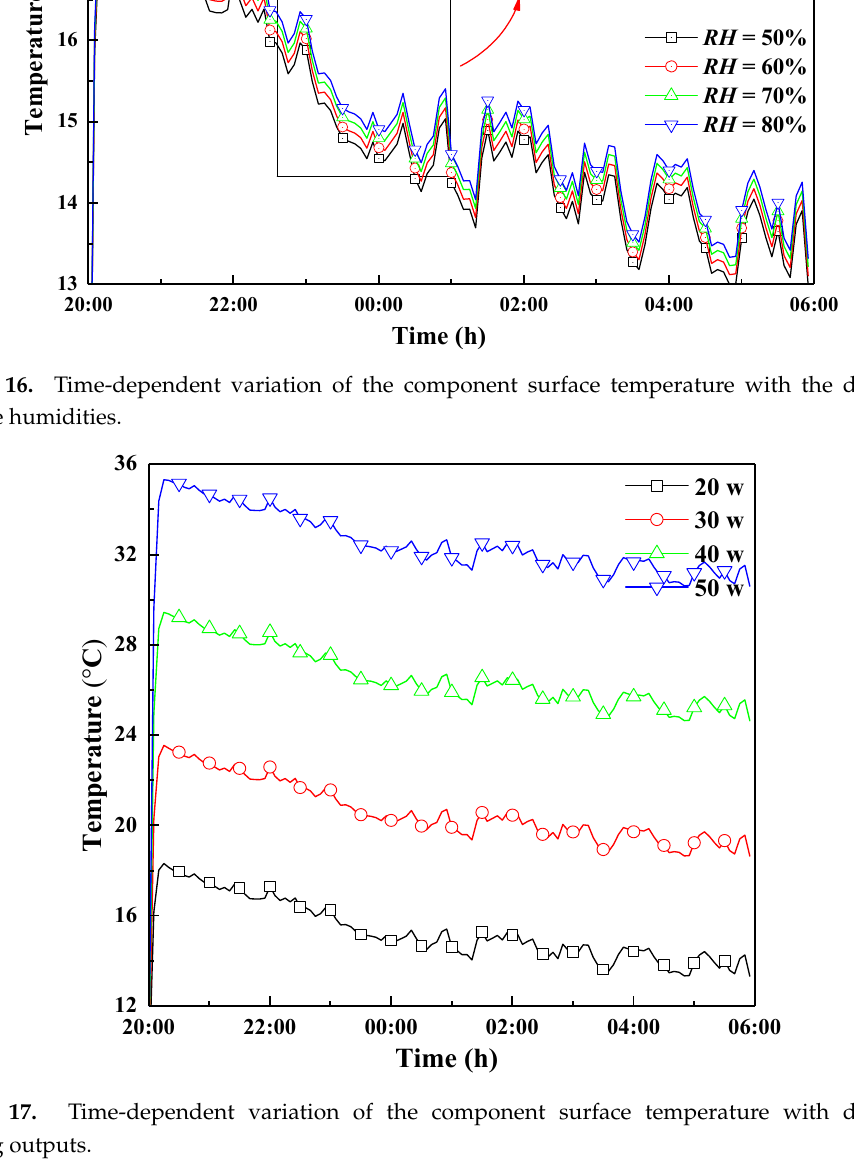
Figure 16. Time-dependent variation of the component surface temperature with the different relative humidities.